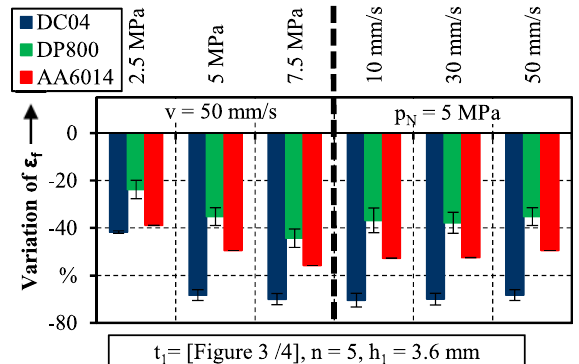
Fig. 10. Modi fi cation of the fracture strain e f in tensile tests after preloading in a drawbead passage with h 1 = 3.6mm.